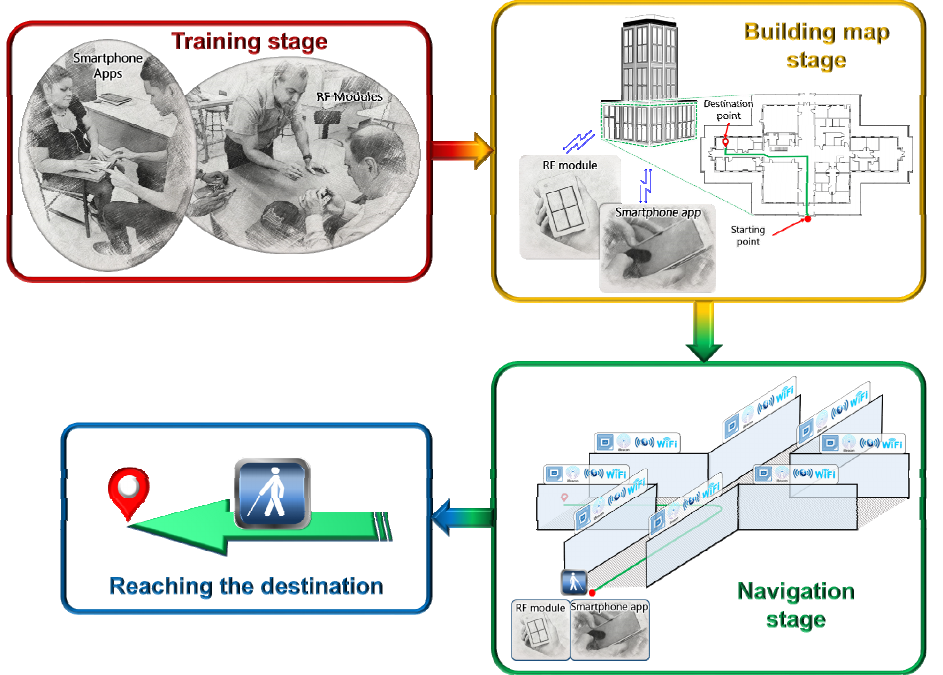
Figure 7. Conceptual Model for movement inside the buildings [10,12,25,26].